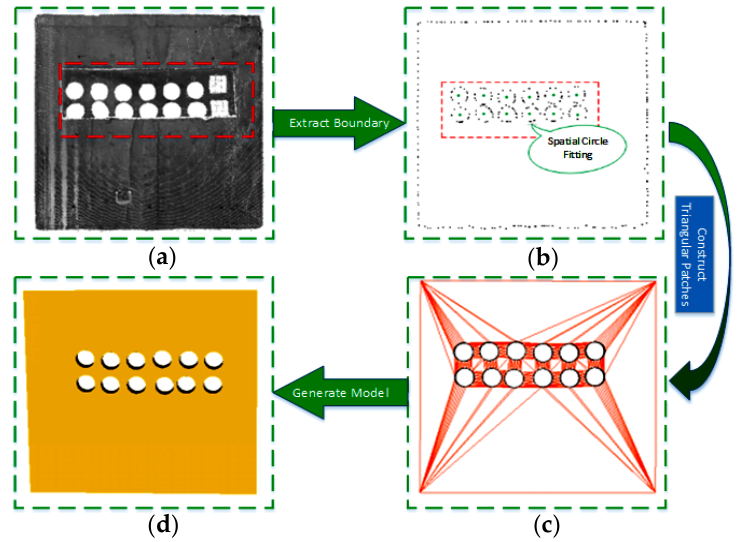
Figure 6. Pipe hole model generation. ( a ) Projected point cloud, ( b ) extracted boundary lines and pipe hole centers, ( c ) constructed triangular patches, and ( d ) generated pipe hole model.